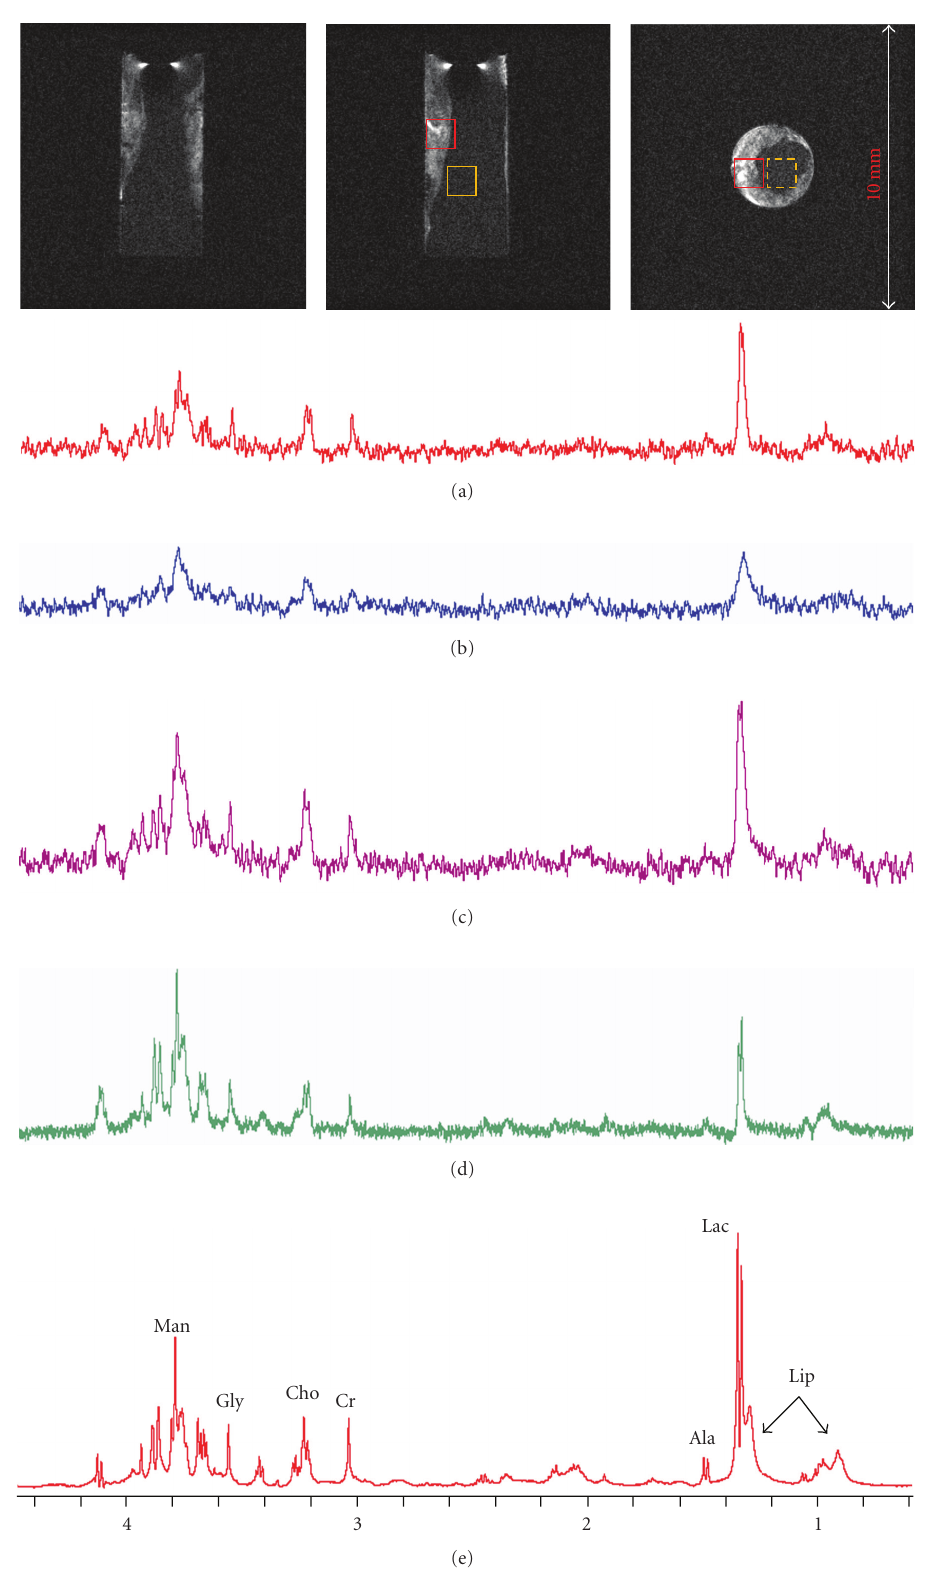
Figure 3: Three orthogonal planes allowed the location of single-voxel in the tissue part (red box) and in the solution (yellow box) for sample G. (a) MRM spectroscopy single-voxel spectra in liquid part, (b) MRM spectroscopy single-voxel spectra in tissue part, (c) the linear combination of spectra (a) and (b), (d) shows the HRMAS CPMG only on the solution collected after the MRM study, and (e) shows the HRMAS CPMG on the whole sample before the MRM